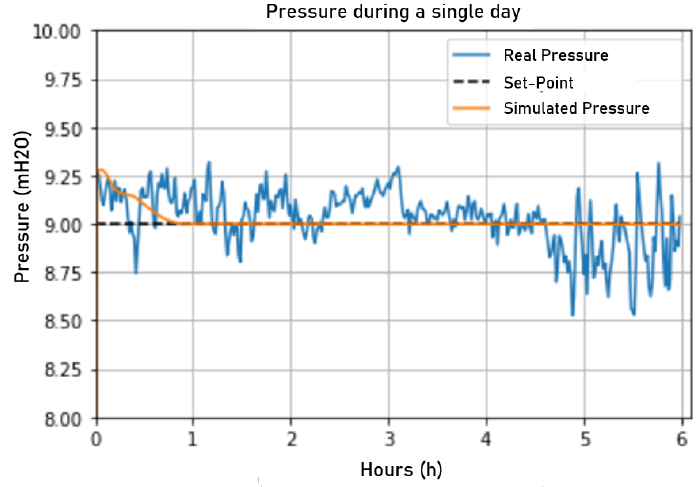
Figure 24. Pressure in the simulated and actual fuzzy networks. Source: author.